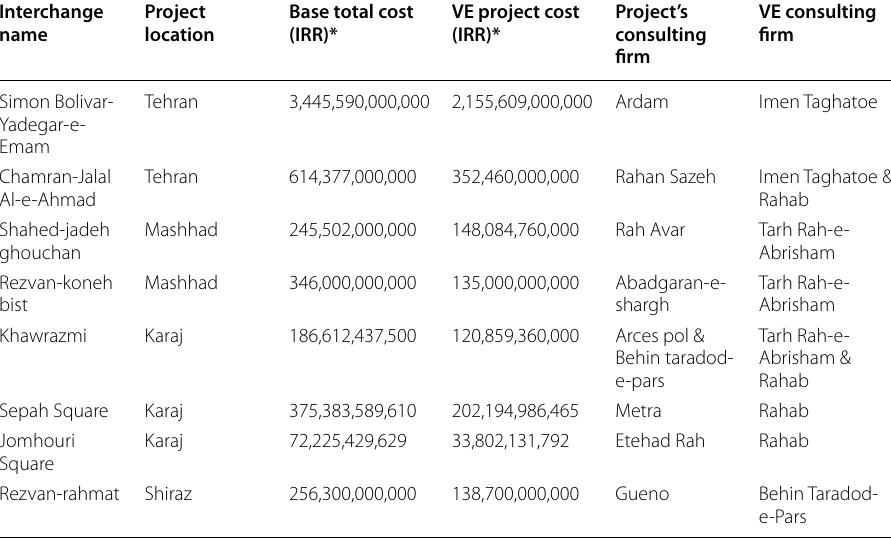
*In the year of the research (2017), each Iranian rial (IRR) was equal to